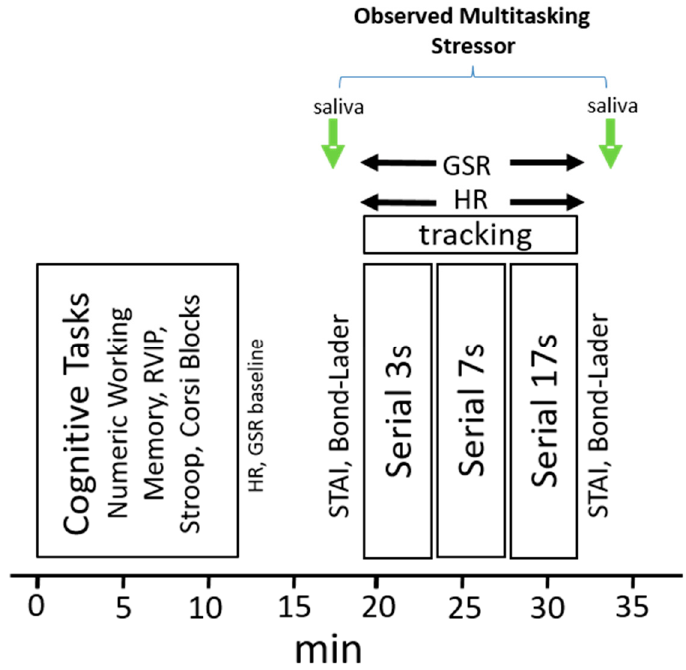
Figure 2. Cognitive and Observed Multitasking Stressor (OMS) assessment. Participants completed a cognitive assessment (Numeric Working memory, Stroop, RVIP, Corsi Blocks) in the general laboratory and then moved to the interview room. They provided a saliva sample (cortisol / α -amylase) and then completed the STAI-state and Bond–Lader mood scales before and after the completion of three four-minute verbal serial subtraction tasks (serial 3 s, 7 s, 17 s, completed in counterbalanced order) and a concomitant computerised tracking task. Heart rate (HR) and galvanic skin response (GSR) were measured throughout performance of the tasks.